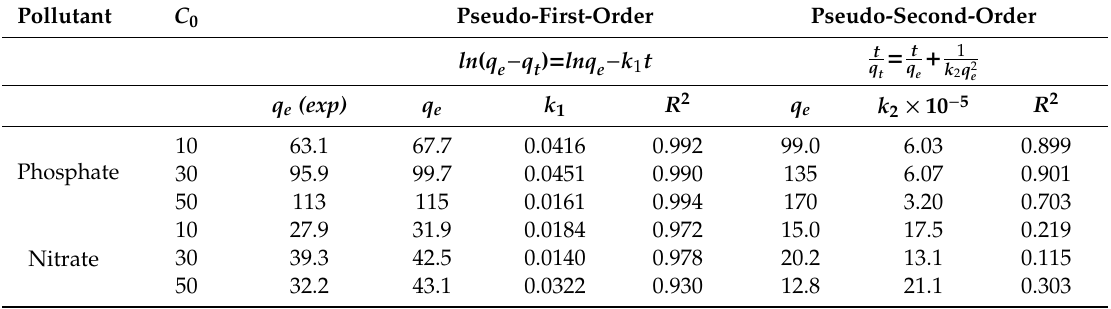
Table 3. Parameters of kinetic models for phosphate and nitrate removal by SBAC 100 MgFe composite.